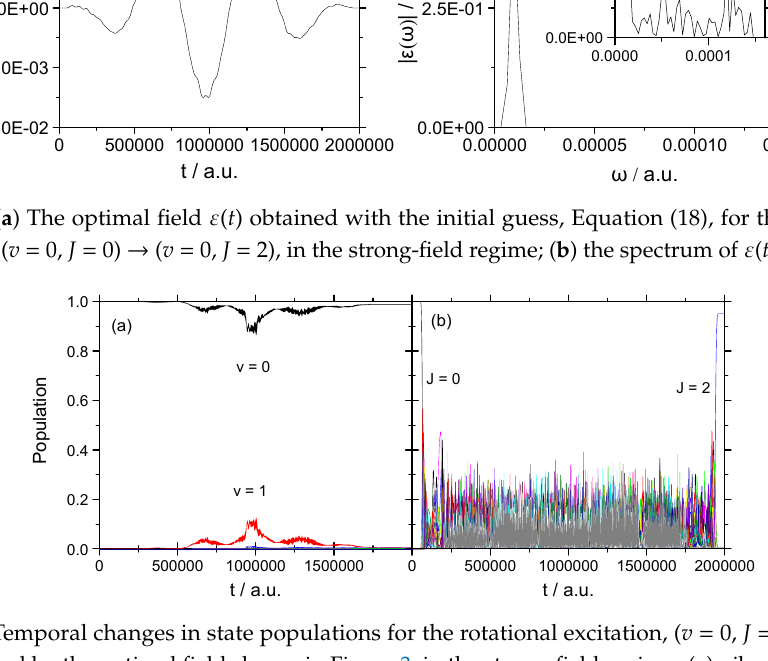
Figure 4. Temporal changes in state populations for the rotational excitation, ( v = 0, J = 0) → ( v = 0, J = 2), caused by the optimal field shown in Figure 3, in the strong-field regime: ( a ) vibrational states; ( b ) rotational states.